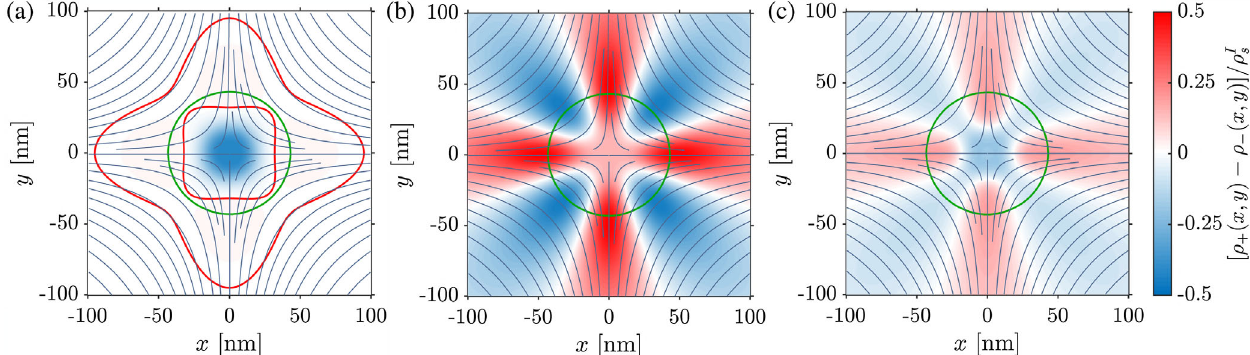
FIG. 8. Net ion-charge distributions ½ ρ g − ¼ 8 , G ¼ 0 . The dark red line is the isosurface ½ ρ surrounding the negatively charged core. (b) Only flexoelectricity ( g G ¼ 10 pC m − 1 ). In all plots, we use κ − 1 q e streamlines indicate the nematic director pattern surrounding the